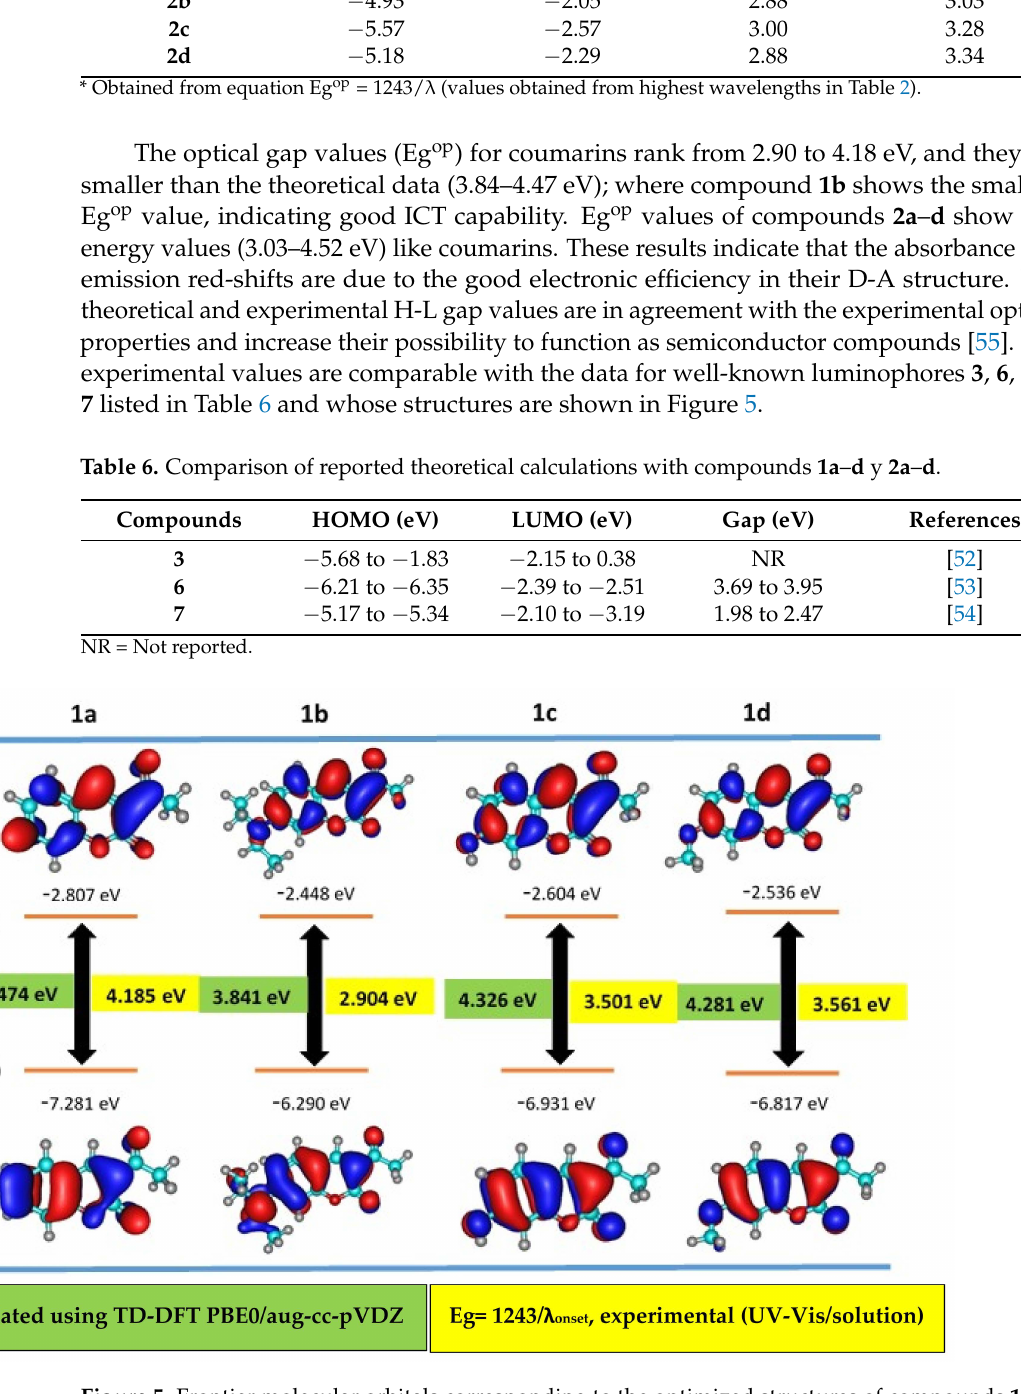
Figure 5. Frontier molecular orbitals corresponding to the optimized structures of compounds 1a – d